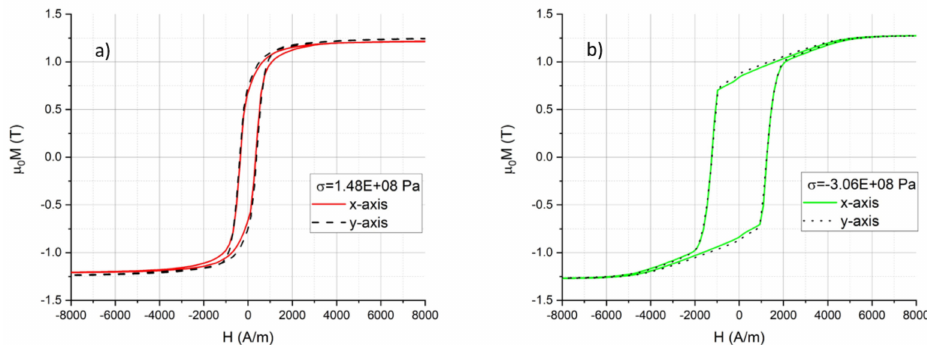
Figure 9. ( a ) Magnetization curves for a sample with tensile stress and ( b ) compressive stress measured along the two perpendicular axes.